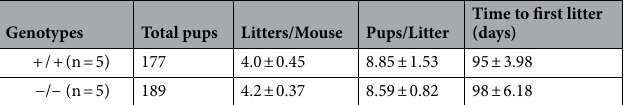
Table 1. Fertility test results of two mouse genotypes.